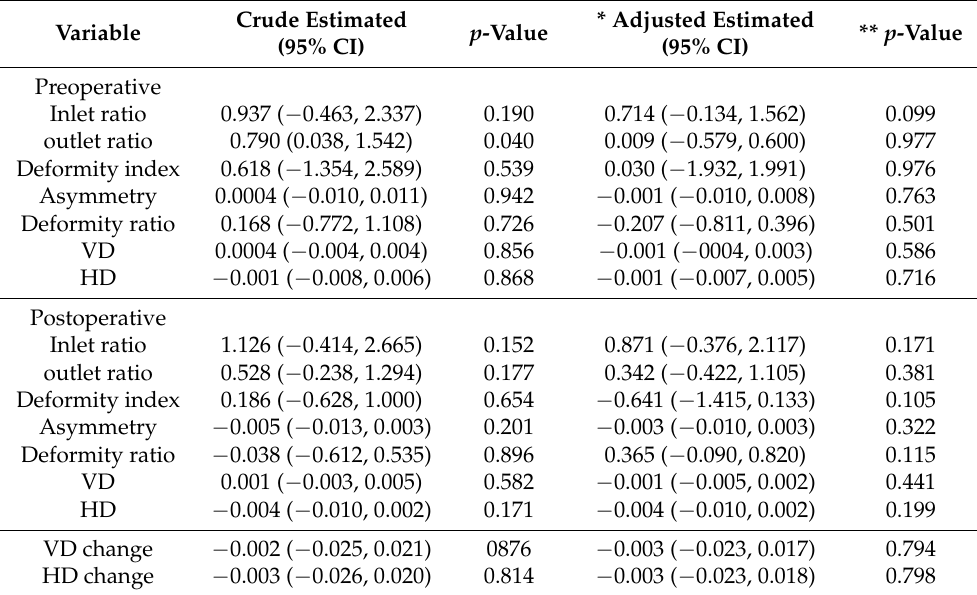
Table 6. Association between the Majeed Pelvic Score and measurements in the GEE model.